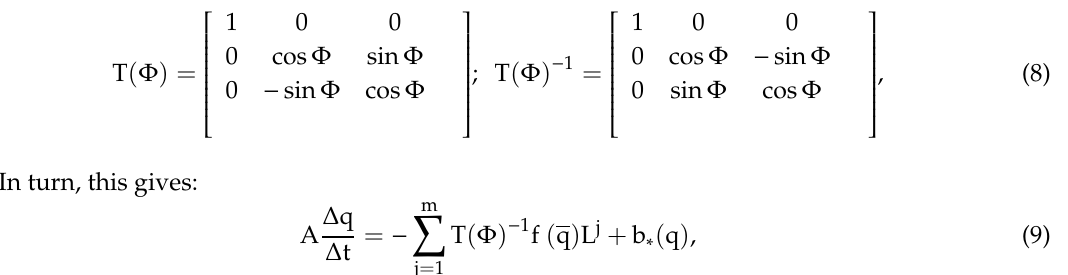
Figure 5. Two-dimensional (2-D) hydraulic model calculation result (water elevation in m).